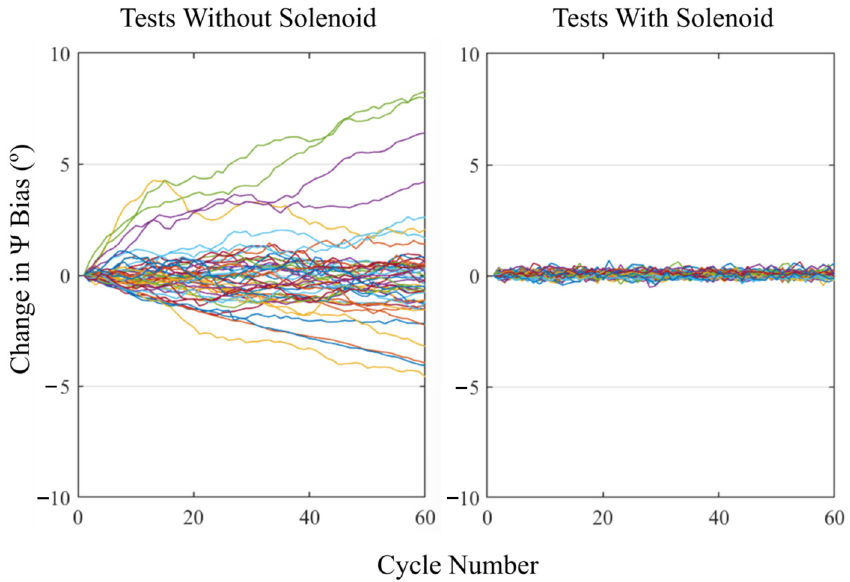
Figure 11. Plots showing the change in bias for rotations about the Z -axis as the tests progressed, for all tests. The left-hand plot illustrates the results for tests without the solenoid and the right-hand plot illustrates the results with the solenoid. Each line represents one test on one tracker, resulting in 50 lines per plot.